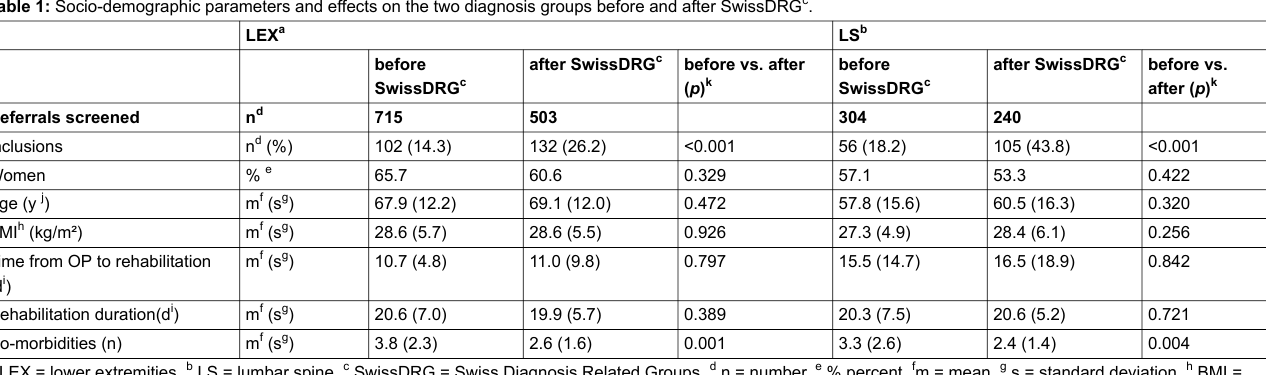
Table 1: Socio-demographic parameters and effects on the two diagnosis groups before and after SwissDRG c .